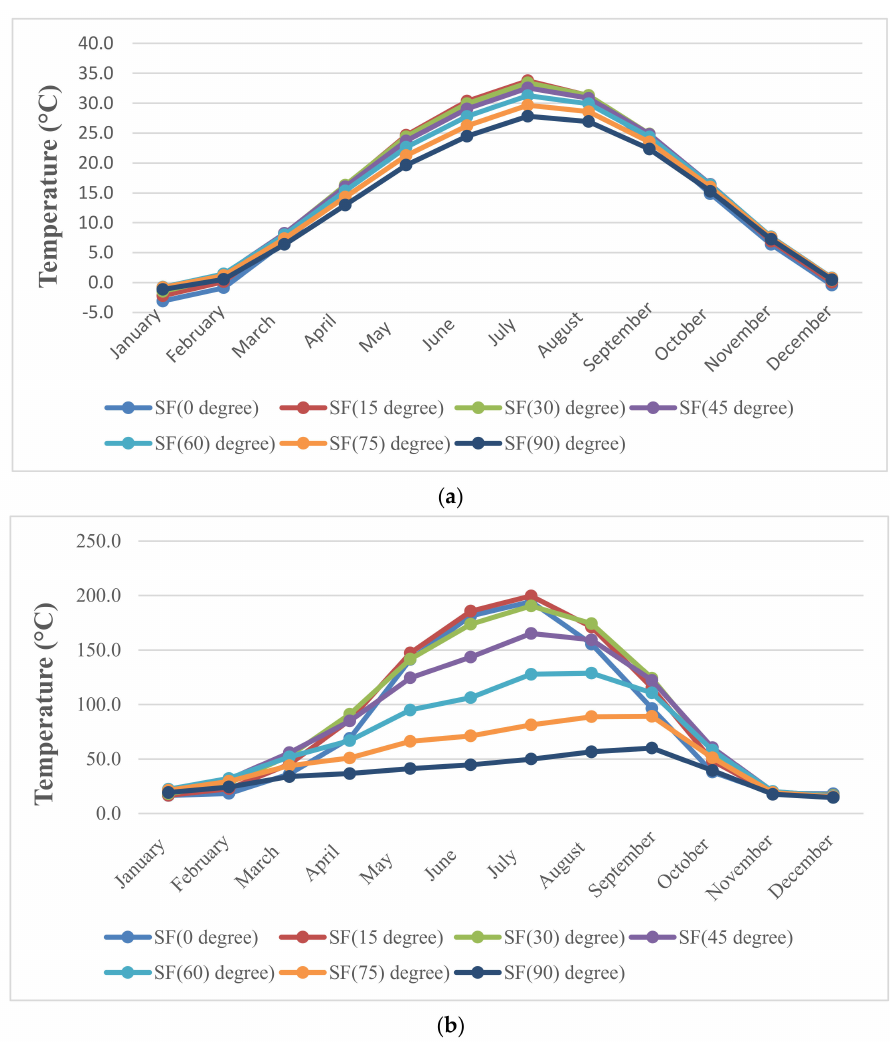
Figure 14. ( a ) Monthly average for daily average temperature of the PV panel surface temperature as a function of tilt angle for PV-R system for the 6:00 a.m. to 6:00 p.m. window; ( b ) Monthly average for daily average temperature of the PV panel surface temperature as a function of tilt angle for MCPVT-HP system for the 6:00 a.m. to 6:00 p.m.